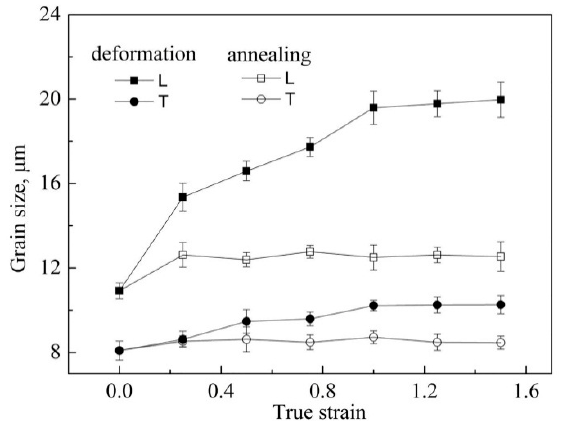
Figure 2. Variation of grain sizes during superplastic deformation and simultaneous annealing at 490 °C and 2 × 10 − 4 s − 1 .